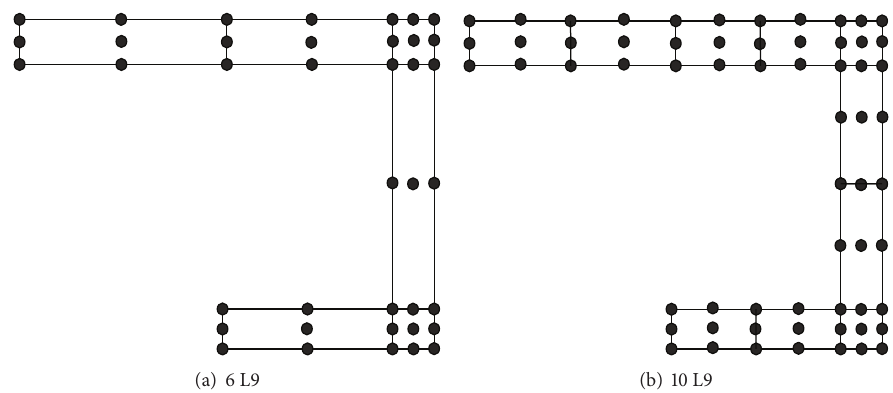
Figure 8: Distribution of L9 elements above the cross-section of the C-shaped beam.